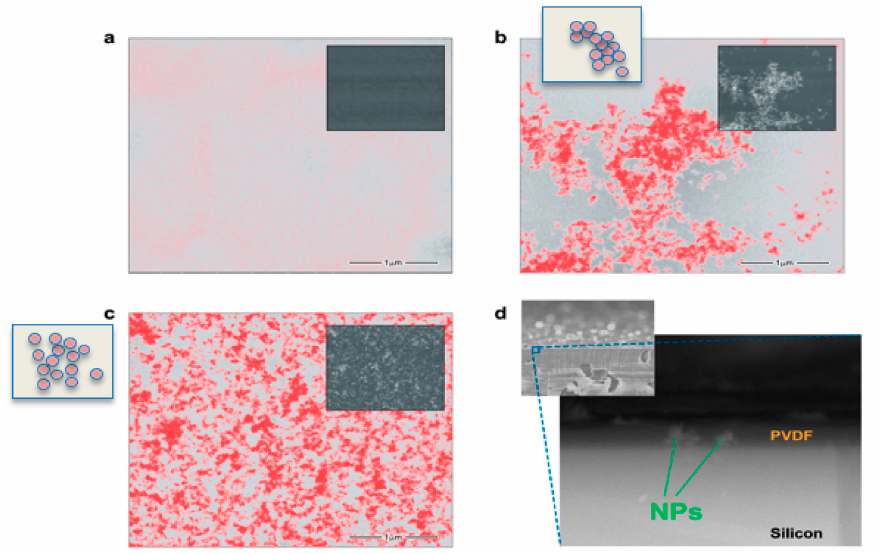
Figure 4. SEM images of ( a ) a neat PVDF film; ( b ) non-functionalized NPs embedded in the PVDF film (NF-PVDF); ( c ) functionalized NPs embedded in the PVDF film (F-PVDF); ( d ) cross-sectional image of the NF-PVDF sample. The scale bar in ( a – c ) is 1 µ m.